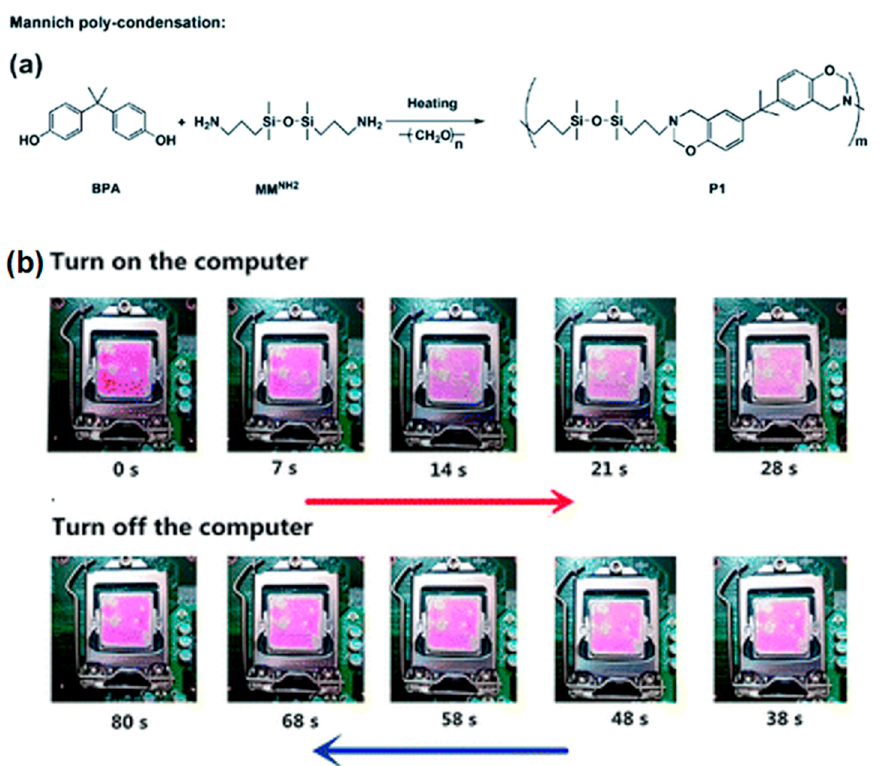
Figure 13. ( a ) Synthesis of P1 by Mannich polycondensation; and ( b ) digital images of a D1-non coated CPU with different running times illustrating the color changes [84] . Copyright 2018, Royal Society of Chemistry.